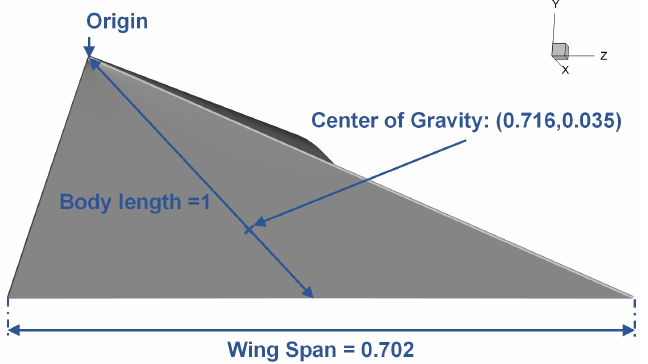
Figure 1. Hypersonic Flight Vehicle